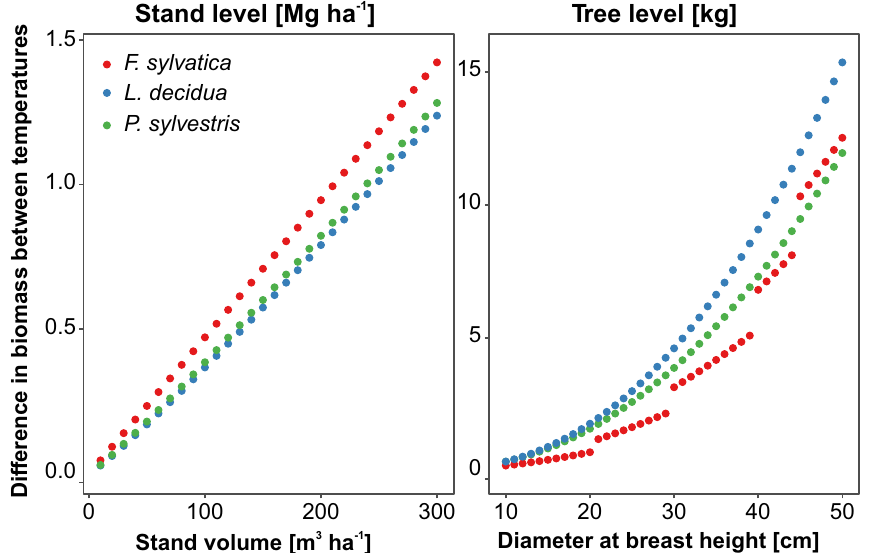
Figure 2. Difference between tree and stand level stem biomass for 75 °C and 105 °C drying temperatures along tree diameter at breast height and stand volume gradients for three example species calculated using species- specific models (Tables S4 and S5). The plot has been generated using R software 38